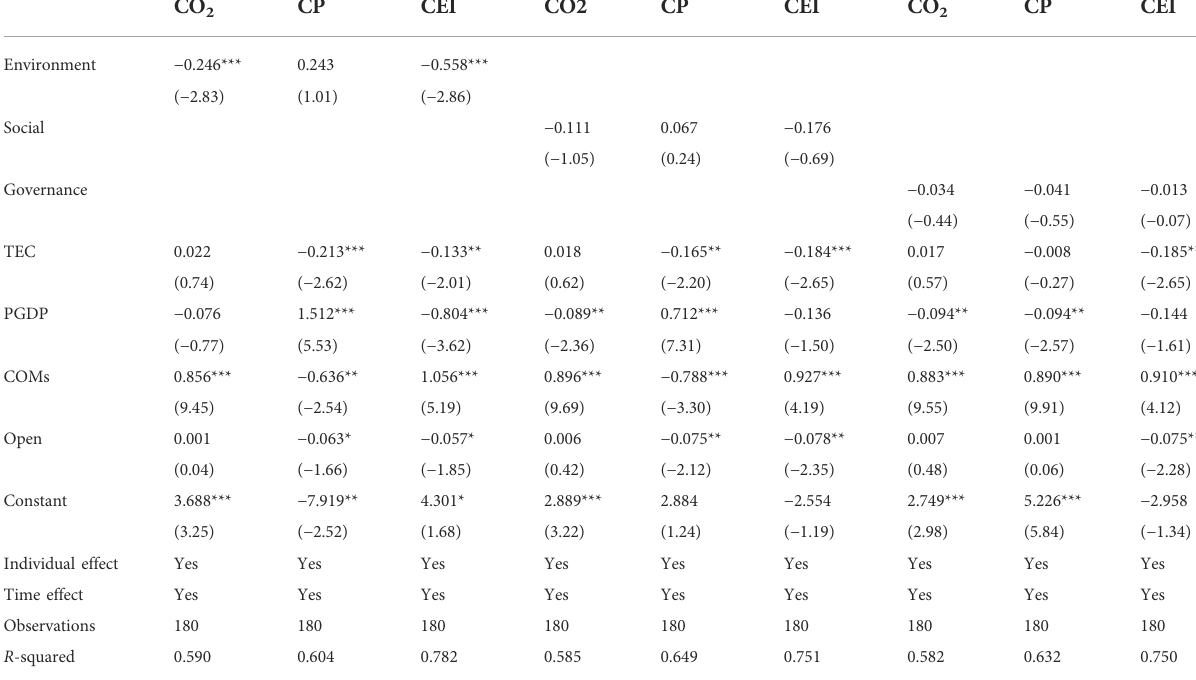
TABLE 7 The effect of Environmental, Social, and Governance investments on carbon emissions.